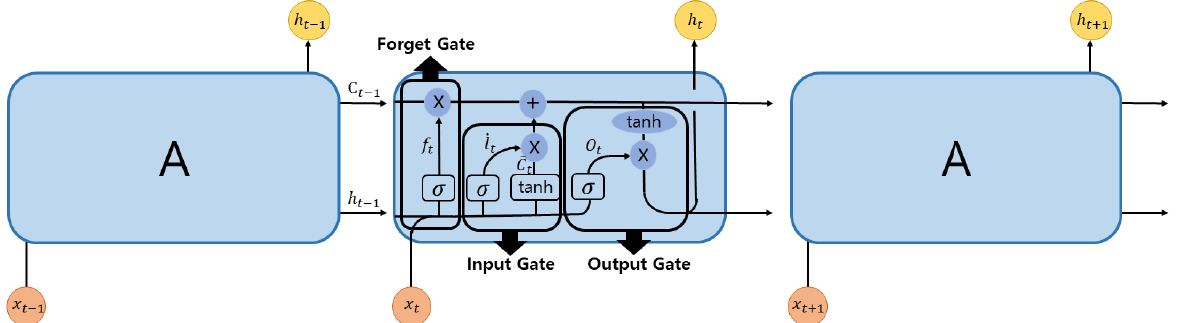
Figure 2. Structure of LSTM.